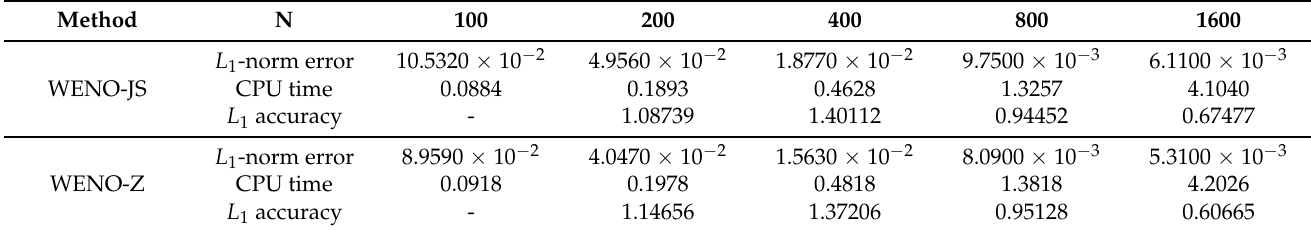
Figure 5. Numerical solutions of Example 2 (Section 6.1.2) on uniform mesh with 200 cells at t = 1 and CFL = 0.1. Table 4. The non-linear Burgers equation accuracy (Section 6.1.2) in 1-D with WENO-JS, WENO-AO, WENO-Z, WENO-AON and WENO-O